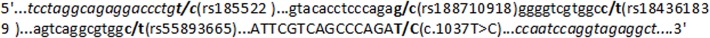
Primers in allele-specific PCR.The forward primer (in italics) ended either in T or C (rs185522), and a common backward primer (in italics) was used. The length of the PCR products was 1.8 Kb. Allele-specific PCR was performed to amplify fragments containing rs188710918, rs184361839 rs55893665, and c.1037.